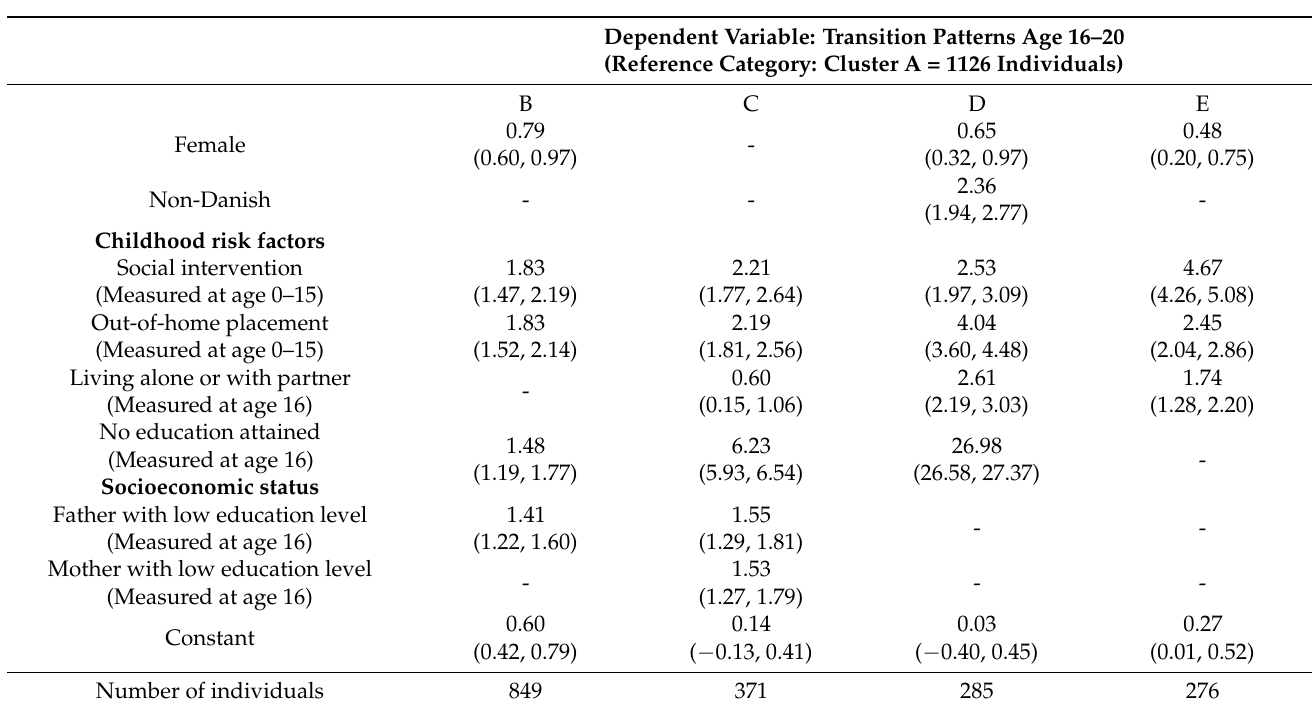
Table 2. Multinomial logistic regression estimates, by cluster; young adults aged 16–20 with a minimum of six months